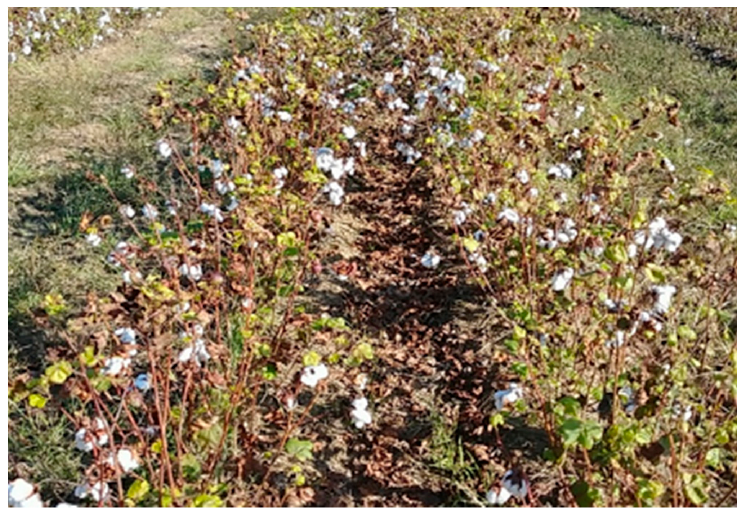
Figure 13. The appearance of the cotton at the time of the field experiment.